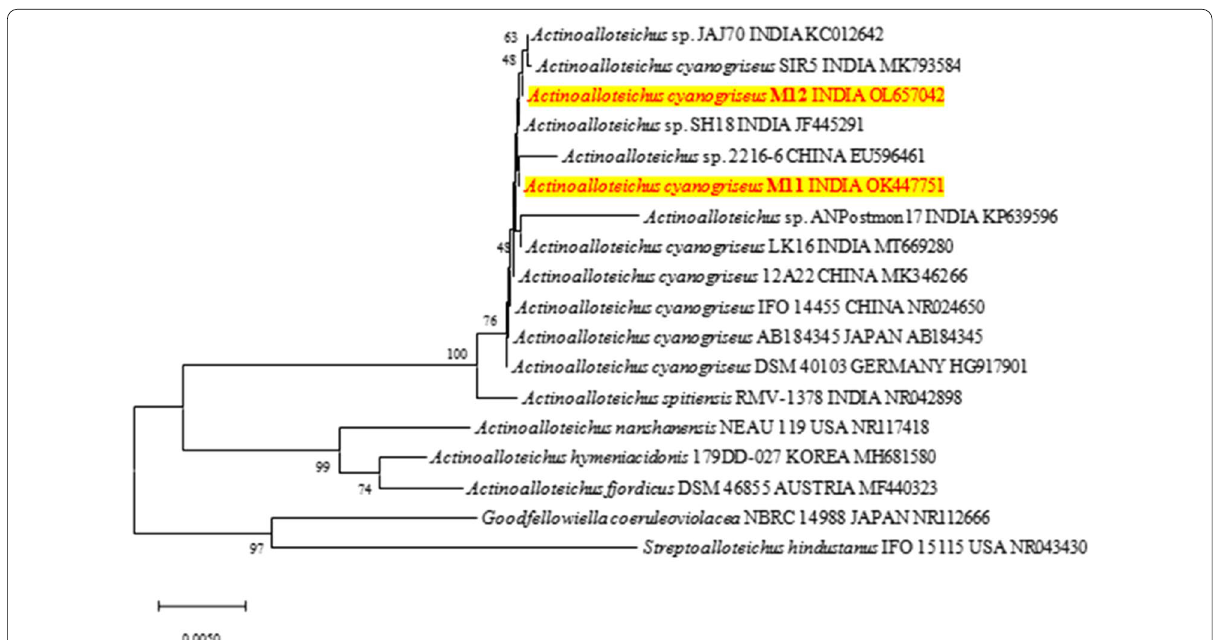
Fig. 4 Neighbor joining (NJ) phylogenetic tree constructed from 16S r RNA sequences of potent isolates along with other 16 sequences belonging to the genera Actinoalloteichus . The sequences were aligned using ClustalW algorithm and adopted pairwise deletion for gaps. The confidence limits estimated from a bootstrap analysis with 1000